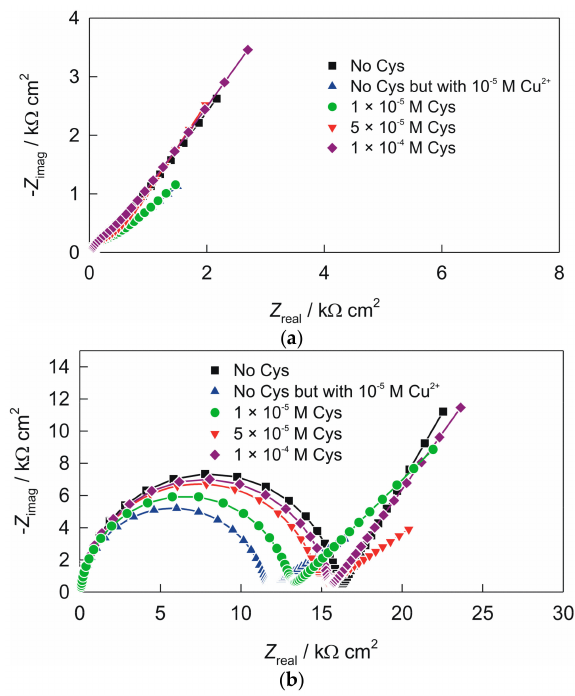
Figure 4. Nyquist plots recorded in 90 mL 0.1 KNO 3 + 10 mL 0.1 M phosphate buffer (pH 7), without and in the presence of various cysteine concentrations (by successive addition of cysteine in the solutions that were spiked with 1 × 10 − 5 M Cu 2+ ): ( a ) electrode “ACS”; ( b ) electrode “AC1.8S”. Frequency range: 100 kHz–0.05 Hz.